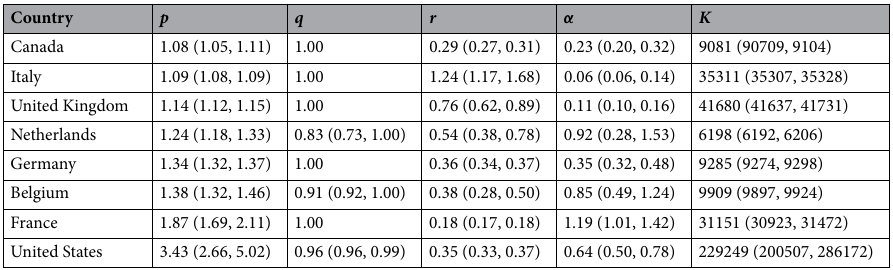
Table 1. Parameter estimates of the BLM for the selected countries. with the respective 95% Confidence Intervals given in